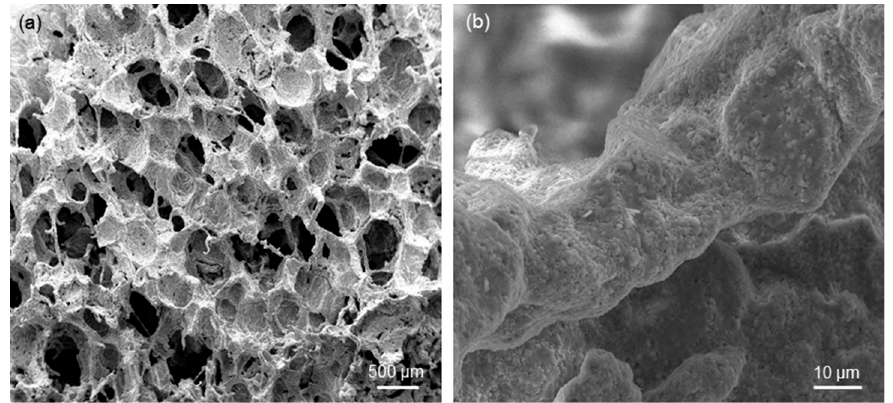
Figure 2. SEM micrographs showing the morphology of 45S5-derived foam-like scaffolds (S-41 sample): ( a ) overview of pore-strut architecture (magnification 50×) and ( b ) detail of a sintered strut (magnification 3000×). Table 1. Porosity and mechanical properties of the 45S5-based scaffolds. Sca ff old Code